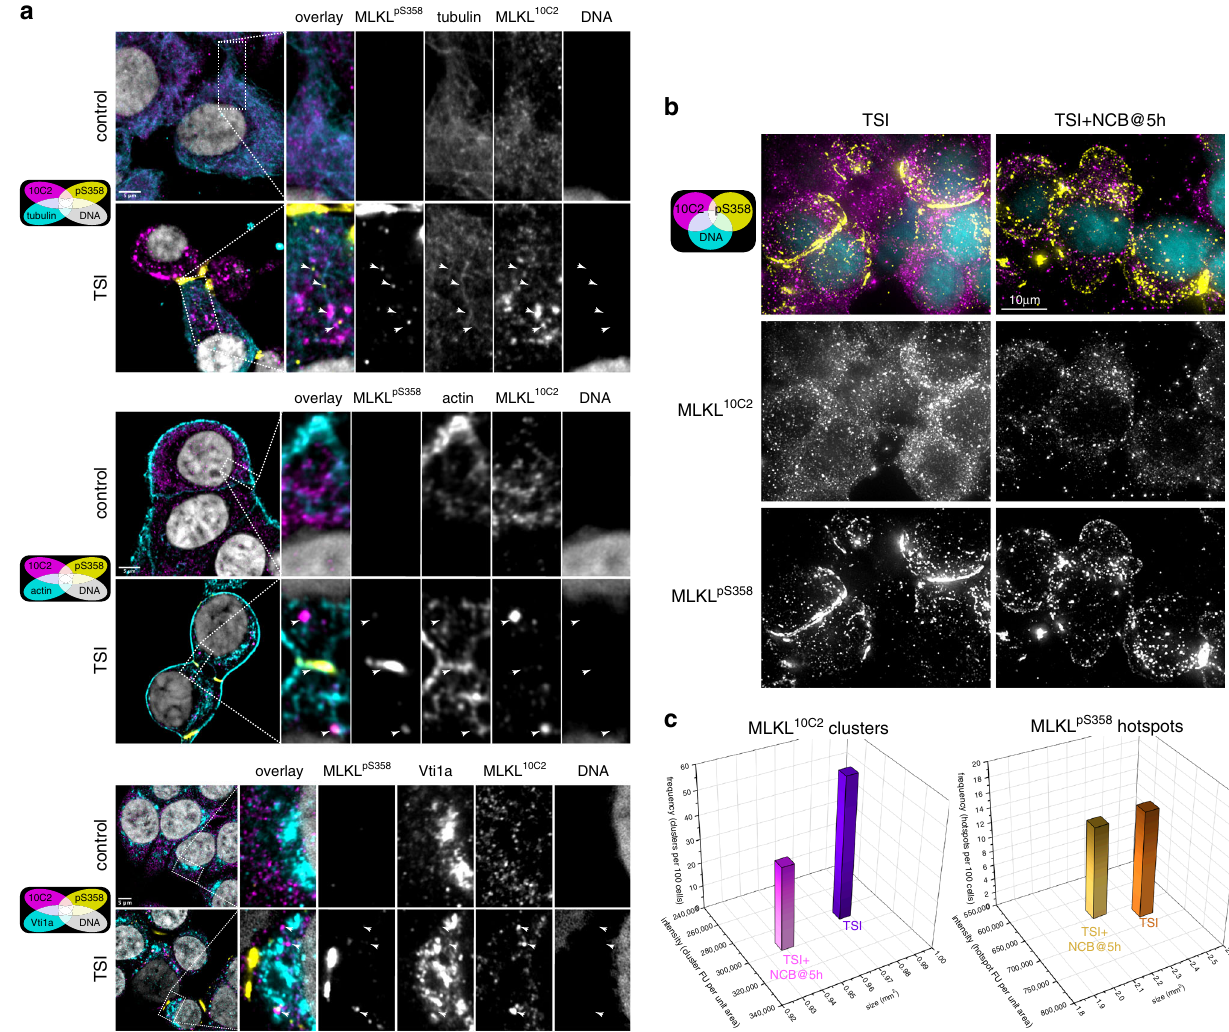
Fig. 7 Microtubule-actin-Golgi machinery traf fi cs MLKL to the plasma membrane. a HT29 cells were left untreated (control) or TNF, Smac mimetic and IDN-6556 (TSI)-treated for 7.5 h, then immunostained as noted and imaged by 3D Airyscan microscopy. Micrographs are single Z-sections. Arrowheads indicate MLKL 10C2 clusters or MLKL pS358 vesicles or MLKL pS358 hotspots that colocalize with actin or tubulin fi laments, and show negligible colocalization between MLKL 10C2/pS358 and the Golgi marker, Vti1a, was observed. Micrographs are representative of n = 2 independent experiments. b – c Nocodazole, Cytochalasin B, Brefeldin A (NCB) was added to HT29 cells after 5 h of TSI-treatment. After 7.5 h of TSI-treatment, cells were stained for MLKL 10C2 , MLKL pS358 and DNA (Hoechst) and imaged via deconvolved 3D wide fi eld ( b ) or epi fl uorescence ( c ) microscopy (representative of n = 3 independent experiments). c Mean frequency, intensity and size of clusters and hotspots across n = 3 independent experiments ( N = 2830 and 2181 cells for the TSI and TSI + NCB@5 h groups, respectively). Independent datapoints in c are shown in Supplementary Fig.